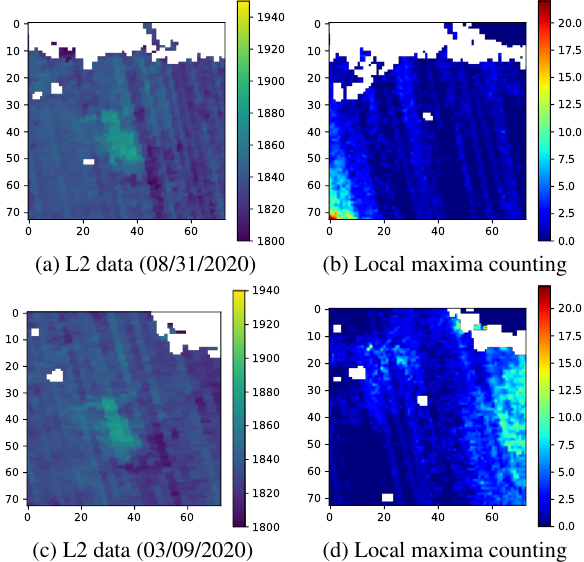
Figure 7. A potential methane plume in Australia at two different dates that is discarded by our